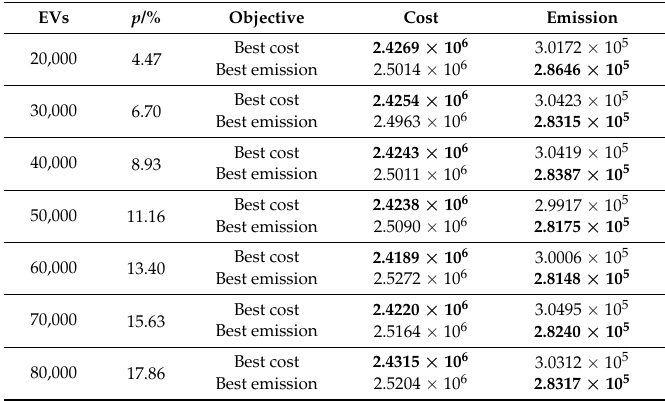
Table 5. Extreme solutions of different